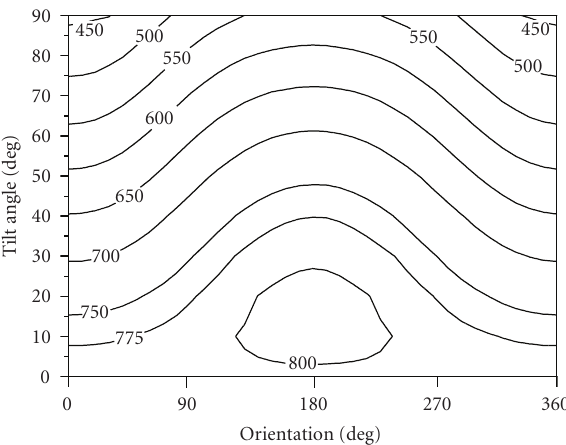
Figure 6: Solar radiation against tilt angles for the south-facing sur-